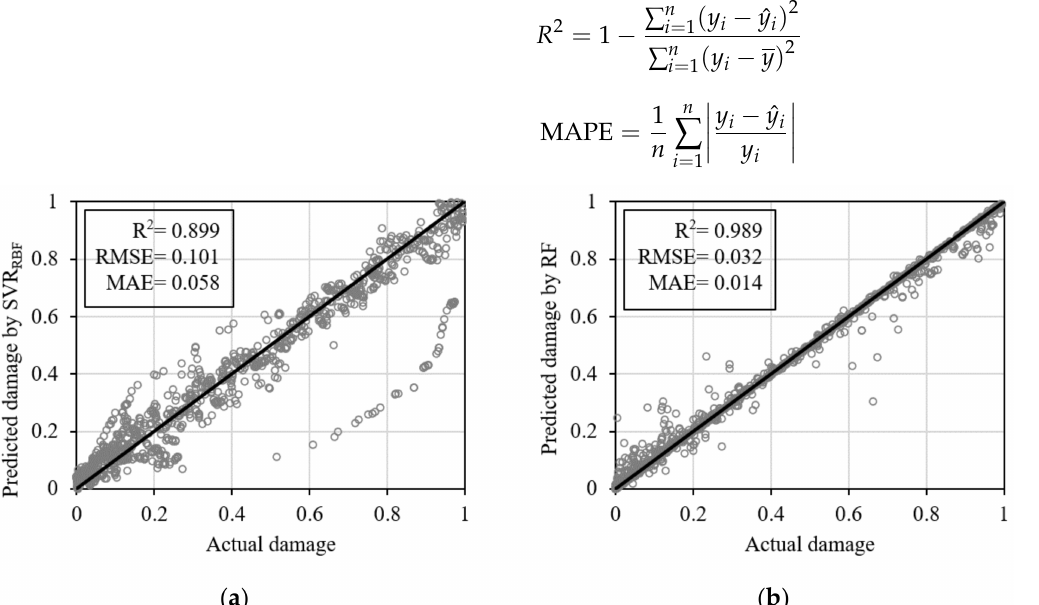
Figure 11. Actual damage versus the damage predicted by ( a ) SVR RBF and ( b ) RF for the testing set. The solid line indicates the relationship y predicted = y Actual . Data points for a good prediction would lie close to the solid line. In Figure 11a, some data points far from the solid line seem to have increased the prediction error. On the other hand, the data points in Figure 11b were overall close to a solid line, which indicates that RF is higher generalization performance compared with SVR RBF